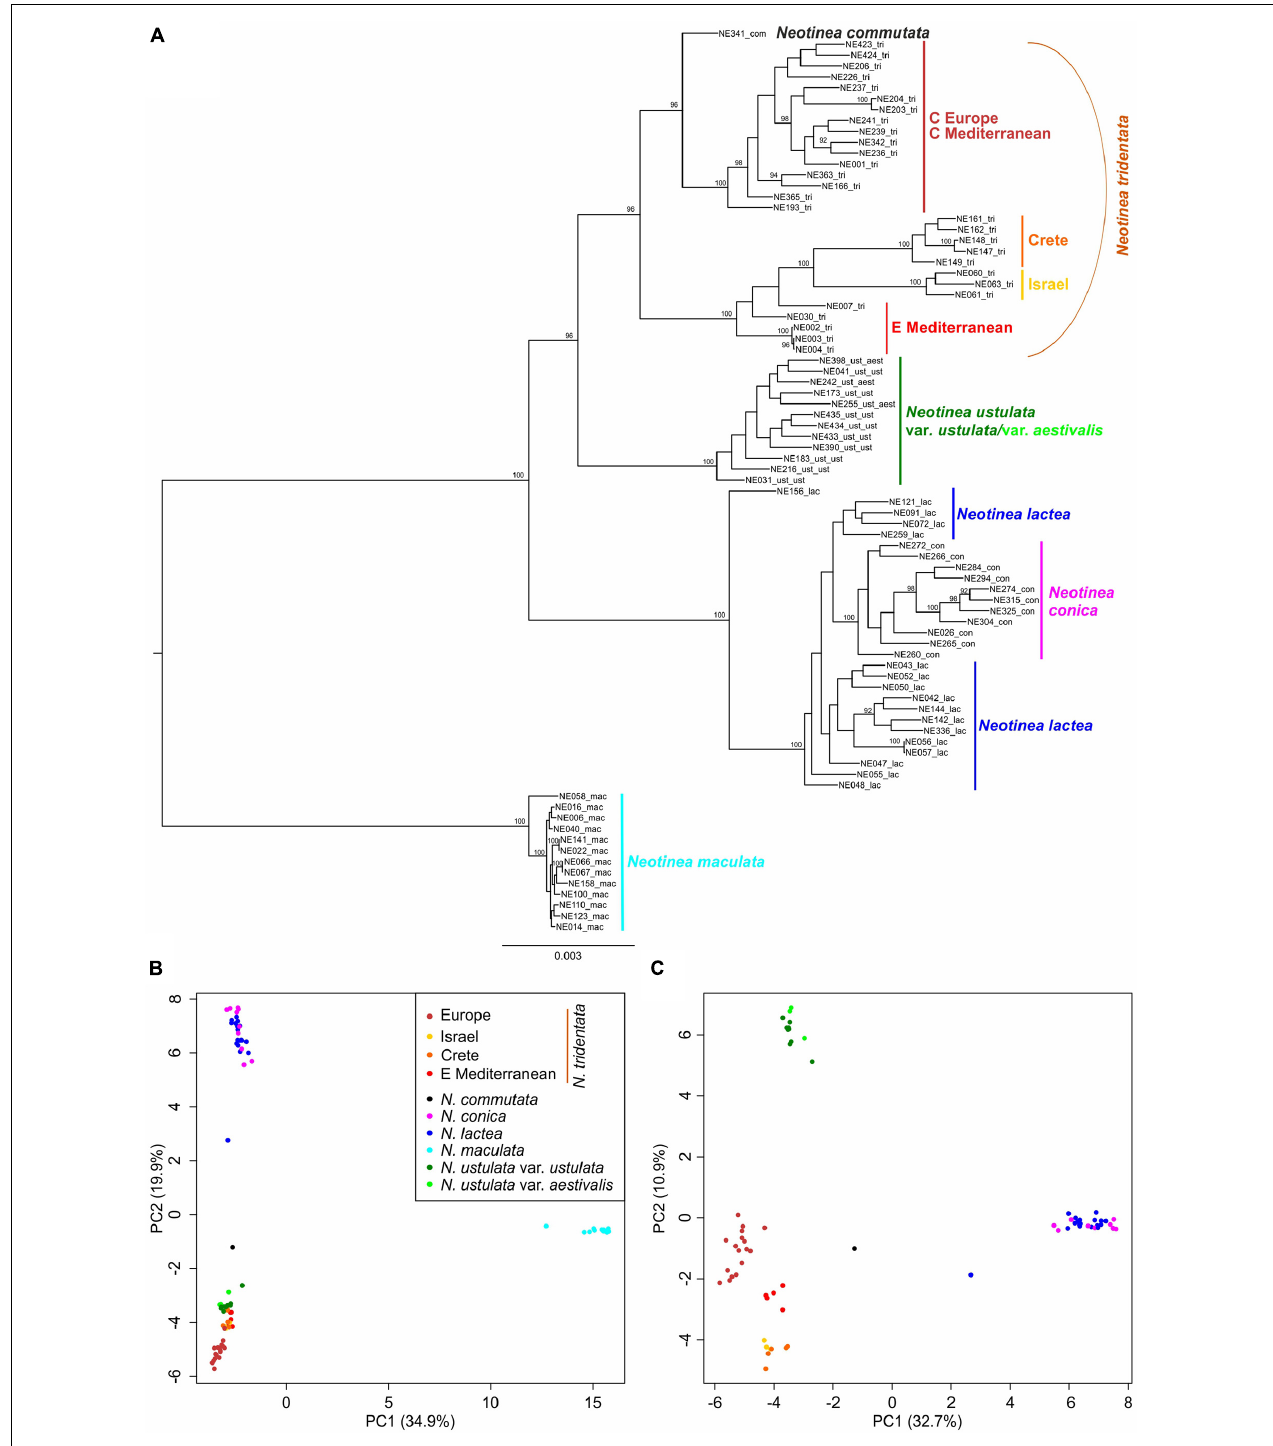
FIGURE 6 | RAxML phylogeny and PCoA analyses based on RADseq-derived SNPs. (A) RAxML phylogeny conducted using all SNPs per locus (16,650 SNPs) is supplemented with bootstrap support (based on 450 replicates inferred from frequency-based stopping criterion; only values above 90% are shown). (B,C) PCoA analyses using a single random SNP per locus (3,090 SNPs) performed with adeneget package in R (Jombart and Ahmed, 2011) on all samples (B) , and without distant N. maculata individuals (C) .